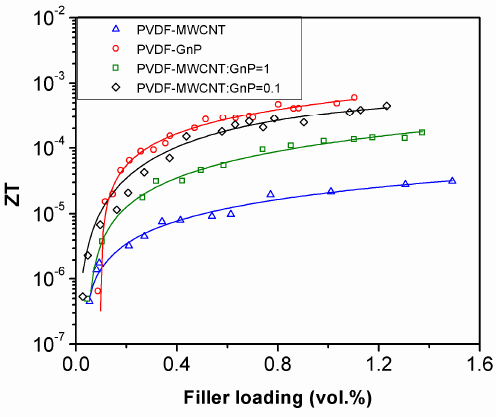
Figure 6. Thermoelectric (TE) efficiencies of PVDF nanocomposite foams as a function of filler